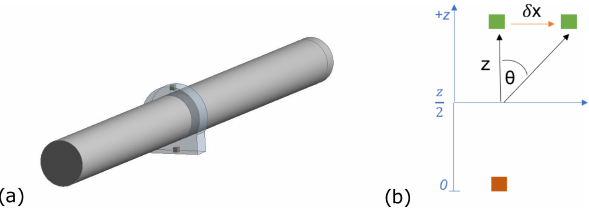
Figure 14. Node selection within the bearing housing for estimat- ing torsional-spring stiffness in the vertical plane.